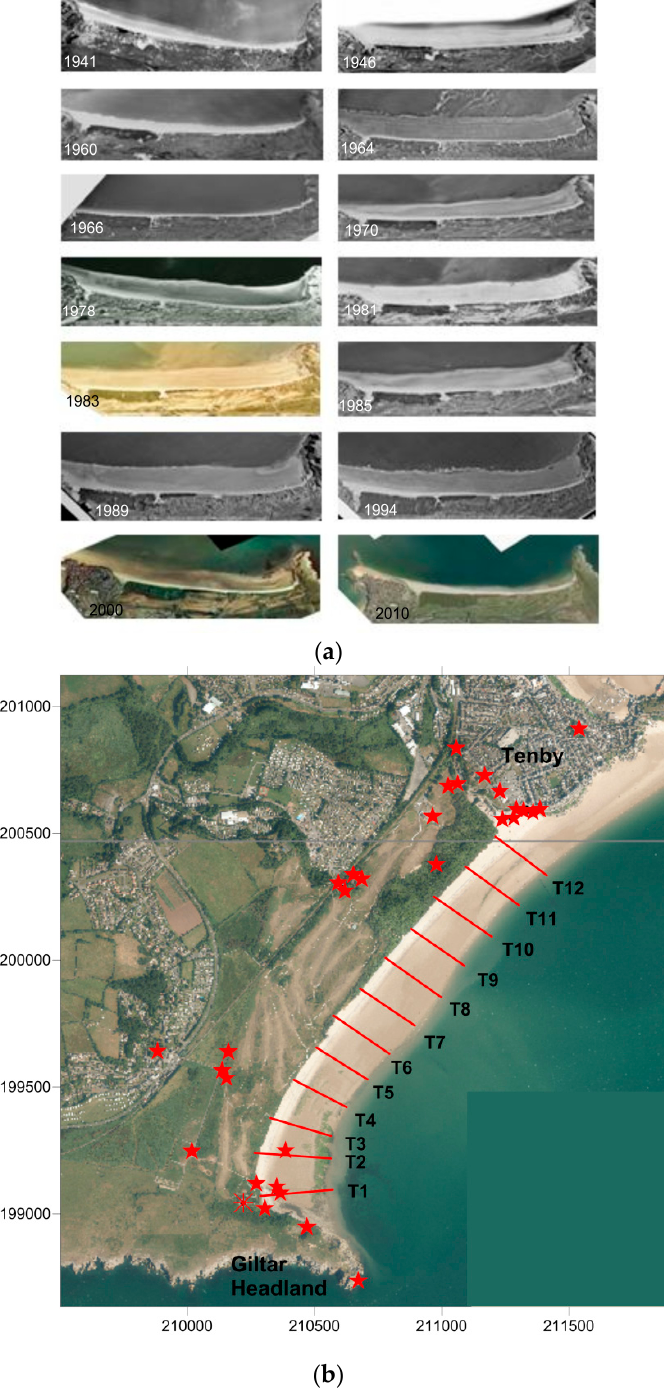
Figure 2. ( a ) aerial photographs depicting South Beach, Tenby prior to the geo ‐ referencing process for the period 1941–2010 and utilized in this research and ( b ) 2014 aerial photograph showing the study area detailing the position of the permanent control points (red stars) used to aid geo ‐ rectification and check RMSE results and transect locations from which morphological variables were computed. Table 1. Aerial photographic source document scales and RMSE results after digitizing.